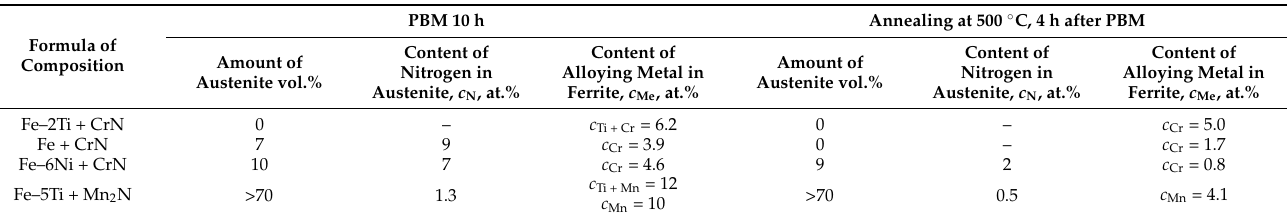
Table 1. Mixture type, composition formula, content of alloying elements, and amount of austenite in the MS alloys after milling and subsequent